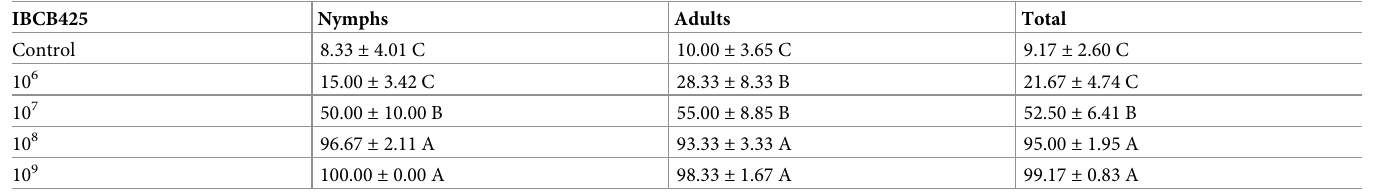
Table 1. Mortality of third instar nymphs and adults of Thaumastocoris peregrinus (Hemiptera: Thaumastocoridae) by Metarhizium anisopliae (IBCB425) (%) in pure conidia concentrations (conidia/mL).